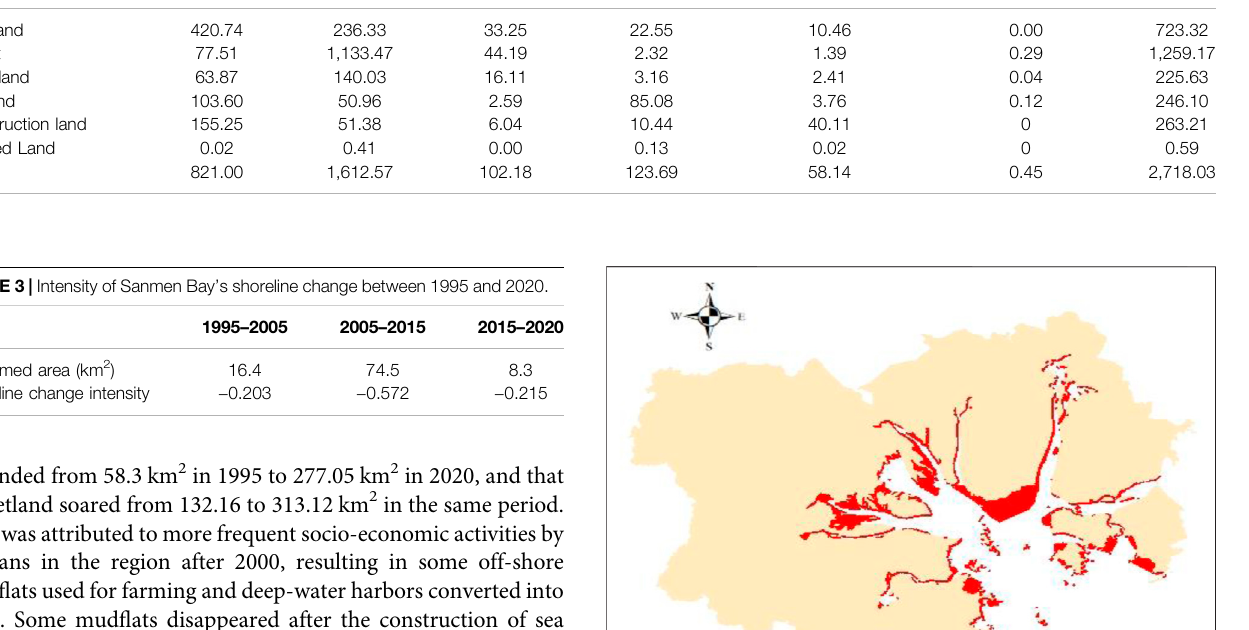
TABLE 2 | Transition matrix on Sanmen Bay ’ s landscape genres from 1995 to 2020 (km 2 ). Landscape genres Farmland Forest Farmland